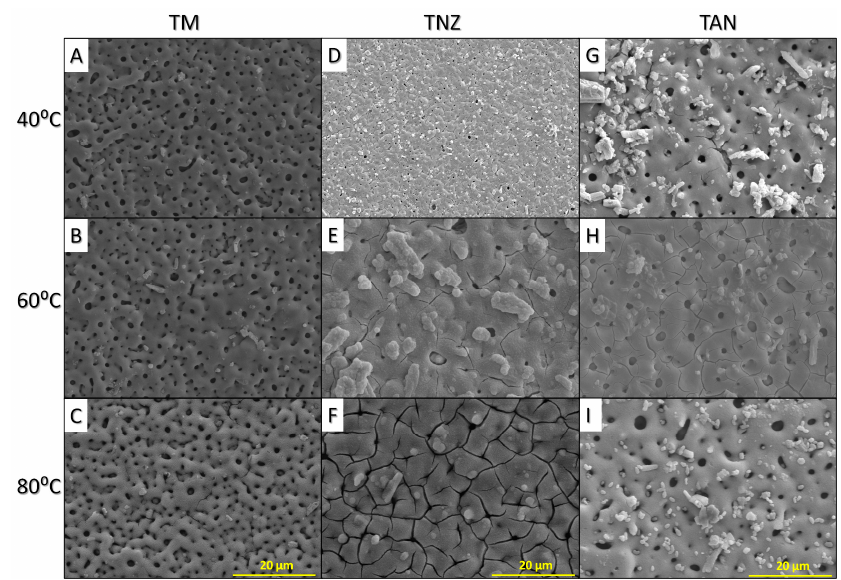
Figure 3. SEM images of the titanium TM ( A – C ), TNZ ( D – F ), TAN ( G – I ) alloy samples after anodization and immersion in 1 M KOH at various temperatures, for 8 h.